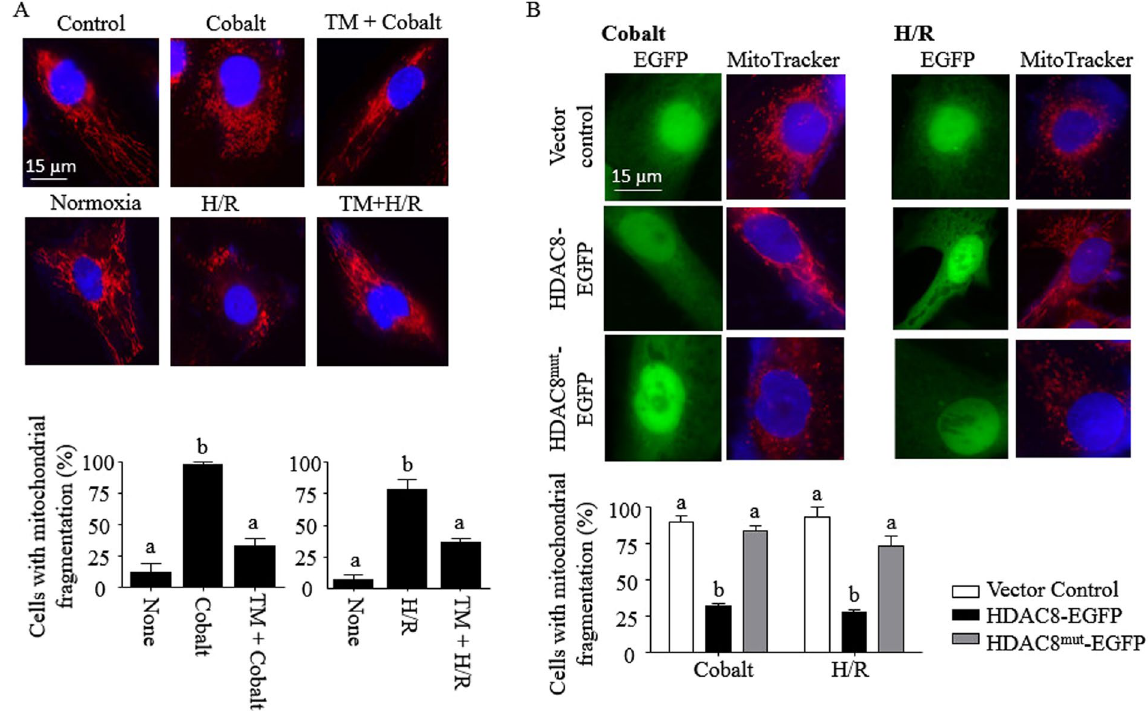
Figure 3. HDAC8 inhibits mitochondrial fragmentation induced by cobalt and H/R in HK-2 cells. ( A , B ) HK-2 cells (A) and HK-2 cells transfected with EGFP (vector control), HDAC8 conjugated with EGFP (HDAC8- EGFP) or deacetylase-defective mutant HDAC8 conjugated with EGFP (HDAC8 mut -EGFP) vectors (B) were exposed to cobalt (300 µ M) for 16–18 h or incubated in the hypoxia chamber (0.2% O 2 , 5% CO 2 & 95% N 2 at 37 °C) for 24 h, followed by a standard cell culture incubator (~21% O 2 , 5% CO 2 & ~74% N 2 at 37 °C) for the next 6 h. Cells were treated with or without TM (25 µ M) throughout the experimental period. These cells were then stained with MitoTracker ® -Red as described in “ Methods ”. Cells were visualized (600x magnification) and representative images of three independent experiments are shown. A total of 50 randomly selected cells ( A ) or 25 EGFP-expressing cells ( B ) from each sample were evaluated for mitochondrial fission. Data are expressed as mean % of cells with apparent mitochondrial fission ± S.D. [n = 3; p < 0.05 by one-way ANOVA with Tukey multiple comparison test; columns accompanied by the same letter are not significantly different from each